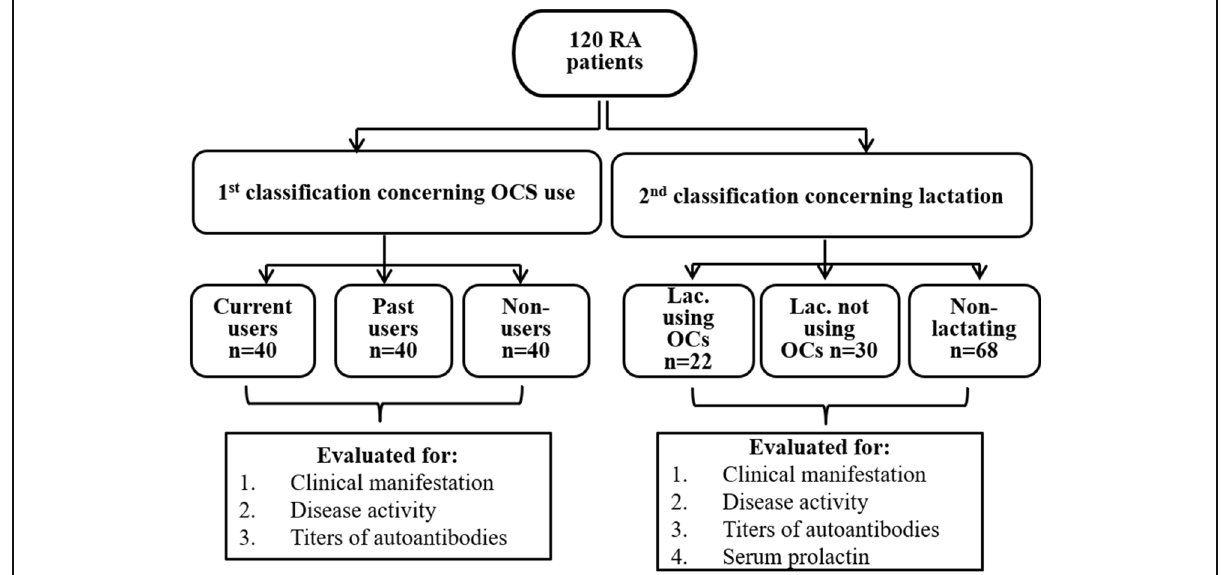
Fig. 1 Flow diagram for patients ’ classification and